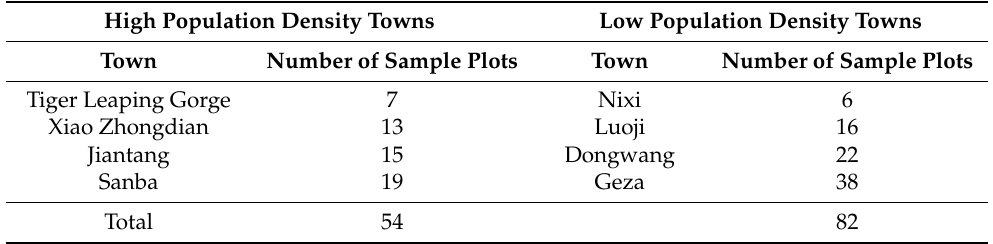
Table 3. The number of high/low population density towns and corresponding sample plots. High Population Density Towns Low Population Density Towns Town Number of Sample Plots Town Number of Sample Plots Tiger Leaping